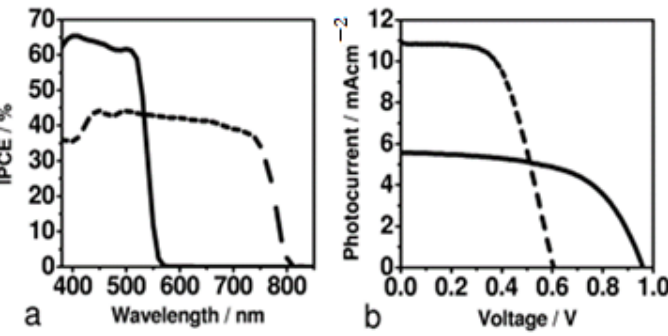
Figure 5. ( a ) IPCE and ( b ) I–V curve for MAPbBr 3 (solid line) and MAPbI 3 (solid line) [5]. Hybrids of mixed-halide PSCs result in synergistic properties not obtained in single halide PSCs. Docampo (2013) compared the optical and PV properties of planar MAPbI 3 single halide and planar MAPbI 3-x Cl x mixed-halide PSCs prepared via a dip-coating solu- tion of PbI 2 thin films into precursor solutions containing (single-halide) MAI plus (mixed- halide) MACl at a controlled concentration ratio (wt%), as shown in Figure 6a. It is ob-